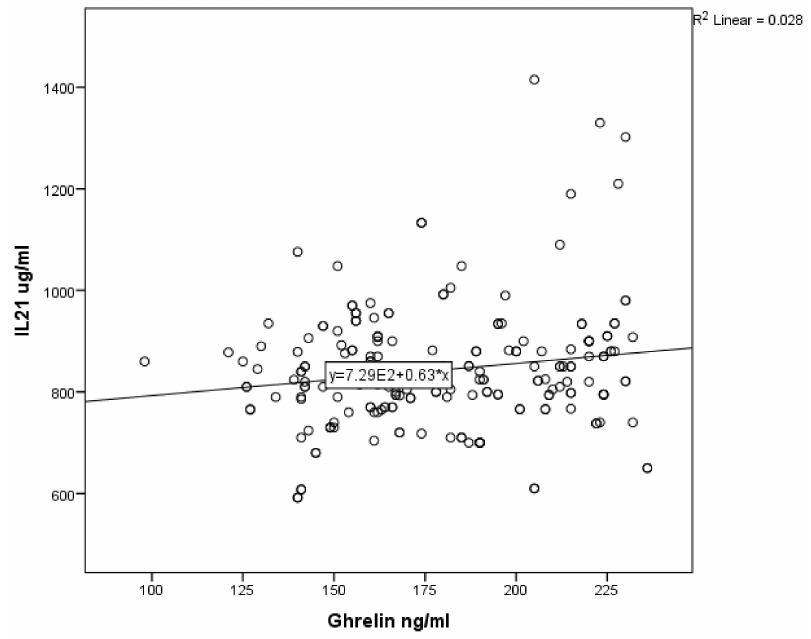
Figure 3. Correlation of serum ghrelin with serum IL-21 in asthmatic children.